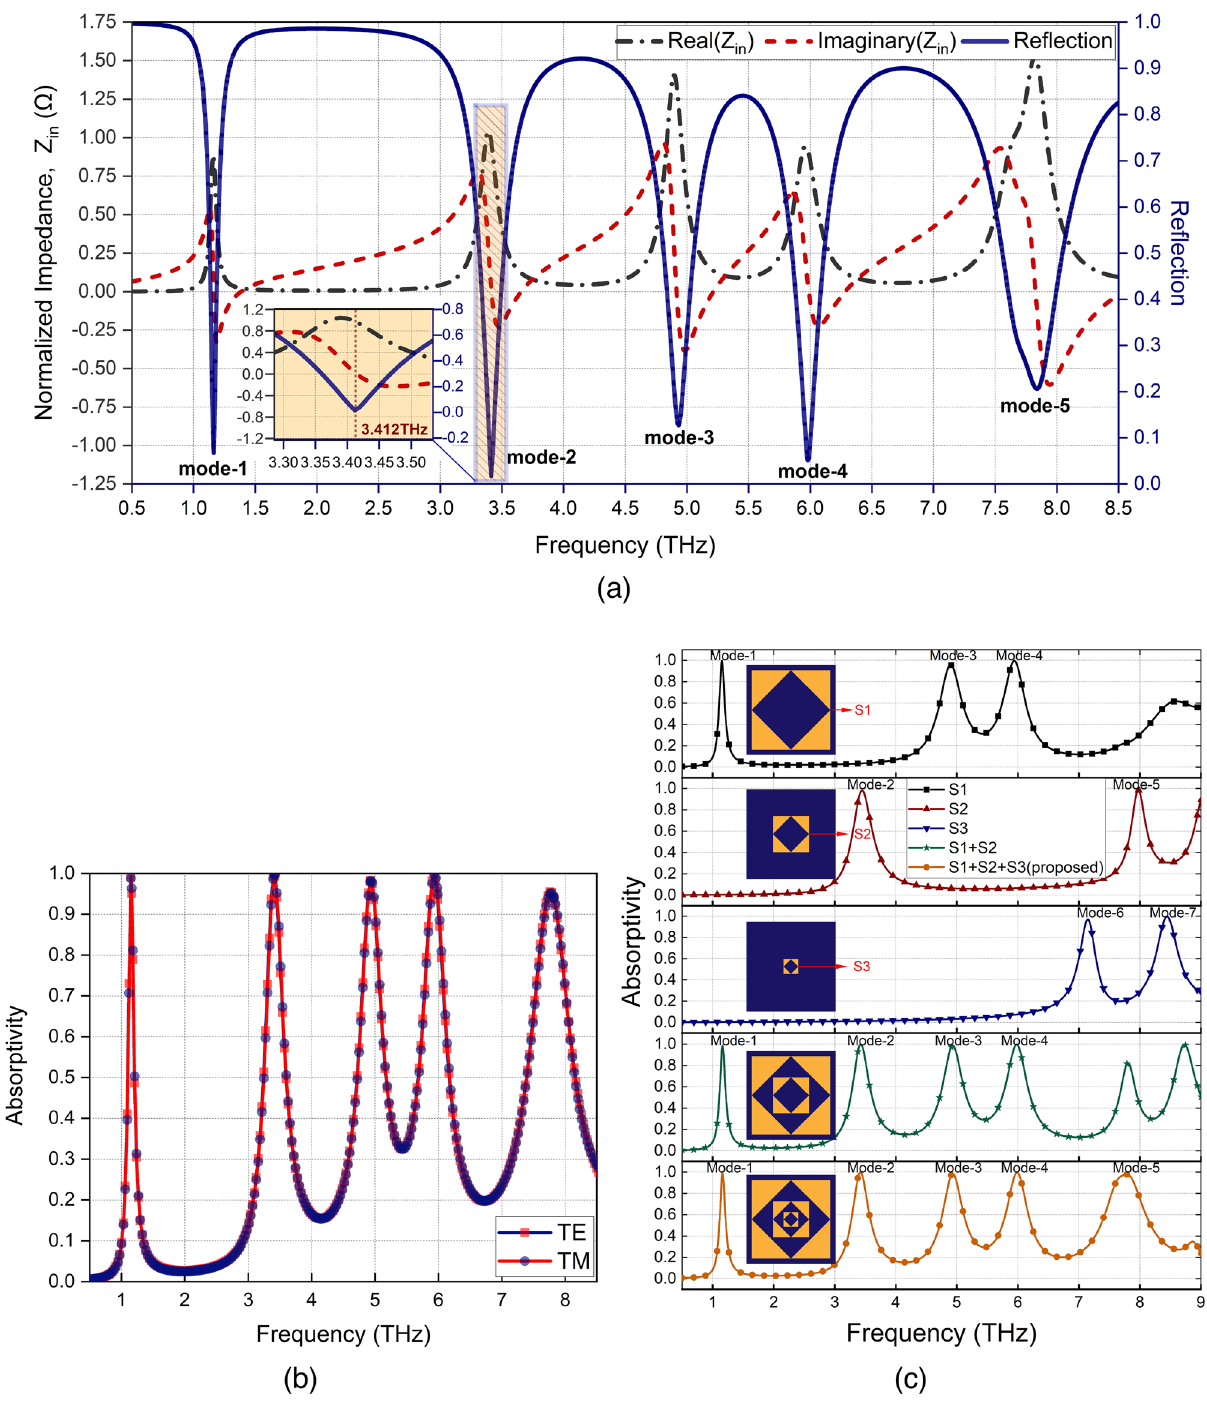
Figure 3. ( a ) Calculated normalized input impedance of the proposed absorber. ( b ) Absorption spectra at the normal incidence for TE and TM polarizations. ( c ) Absorptivity of each resonator and final